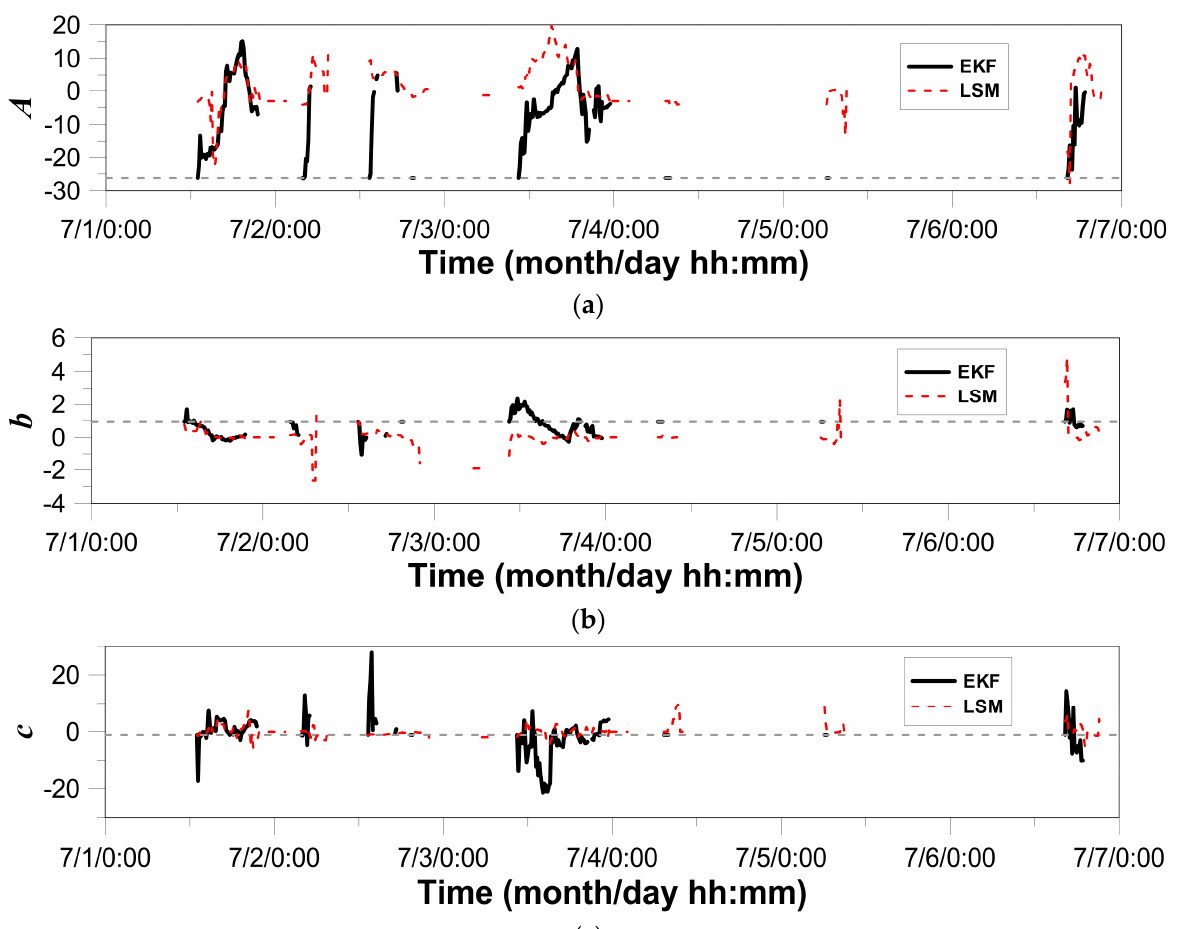
Figure 7. Comparison of time series plots of estimated parameters at the Shinpo rain gauge station (No. 936) by applying the extended Kalman filter (EKF) and the least squares method (LSM): ( a ) parameter A , ( b ) parameter b , ( c ) parameter c .